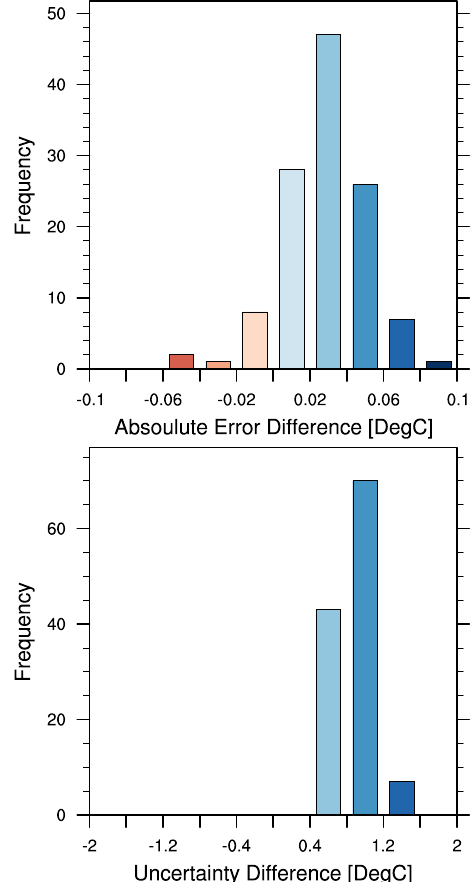
Figure 8. The histograms of the globally averaged differences of ab- solute error and uncertainty. The upper panel shows the histogram of the globally averaged difference between the absolute error of the climatology and that of the EGA forecaster. The lower panel shows the histogram of the difference between the uncertainties of equally weighted and EGA-weighted ensembles. Both quantities show sig- nificantly improved performance of the EGA